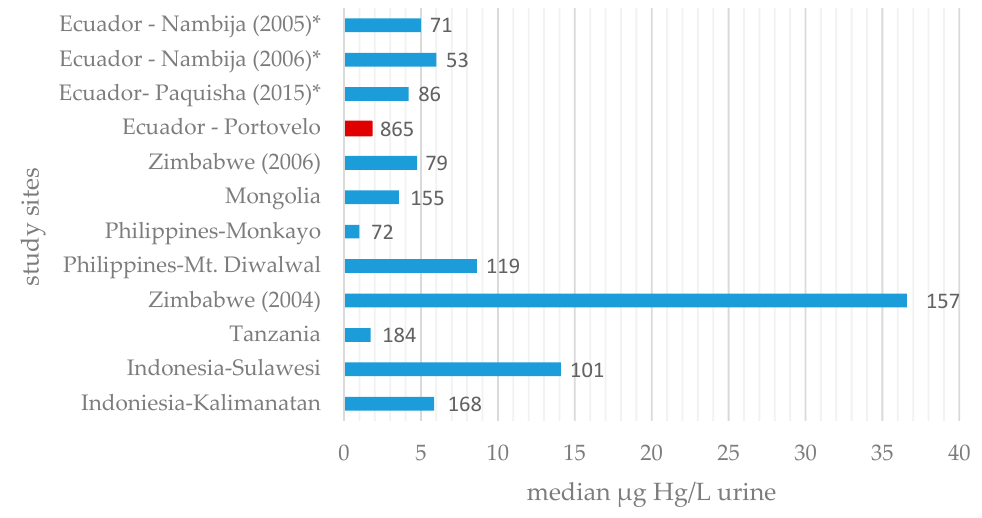
Figure 6. Mean mercury in urine values ( µ g/L) in comparison with other study populations [7,8,14,26,27];